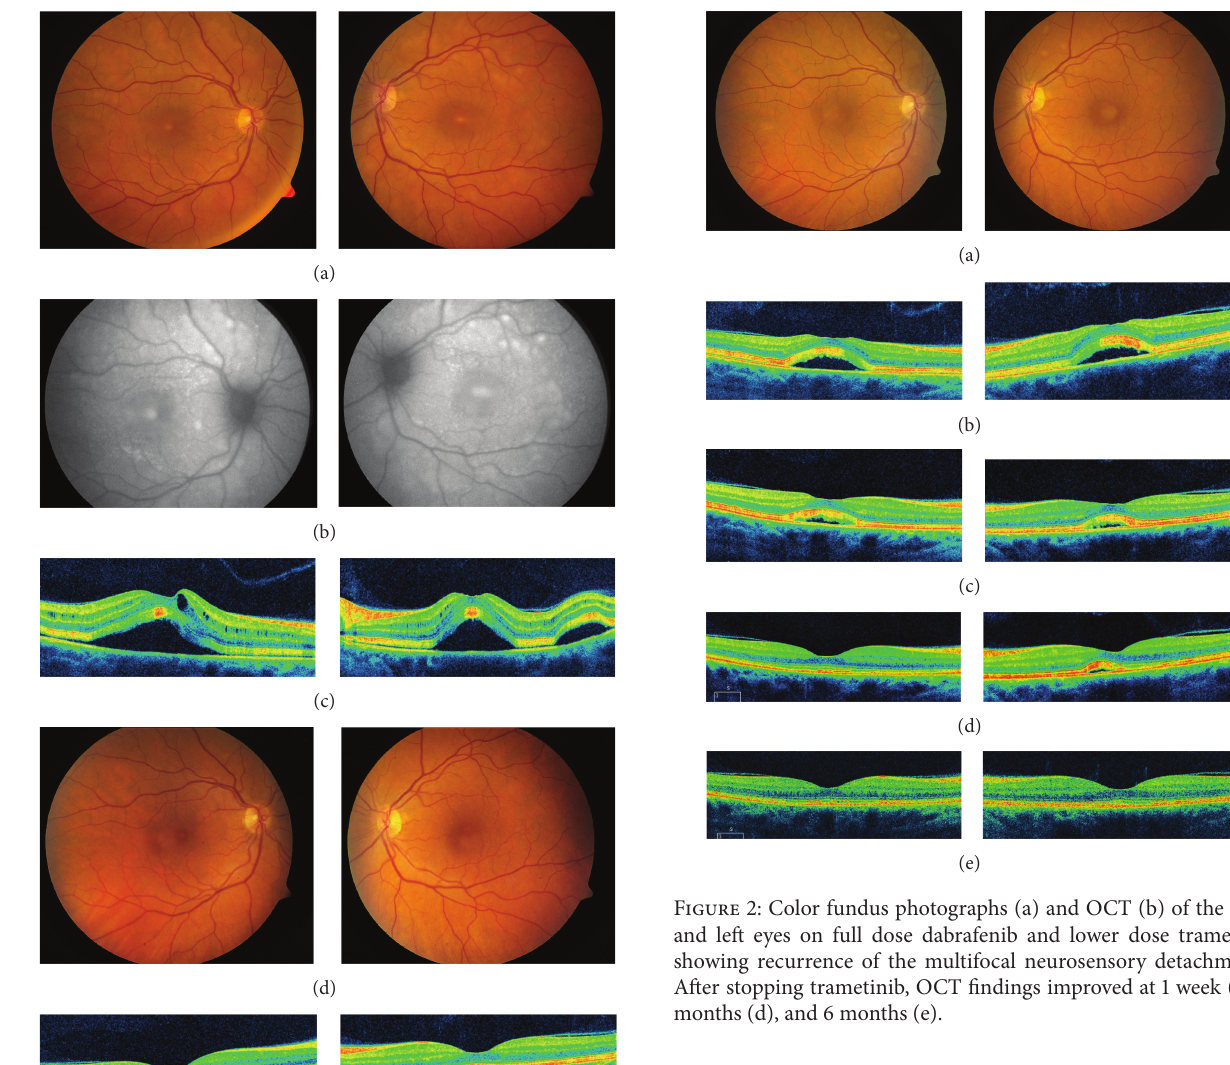
inhibition that may occur with prolonged therapy.